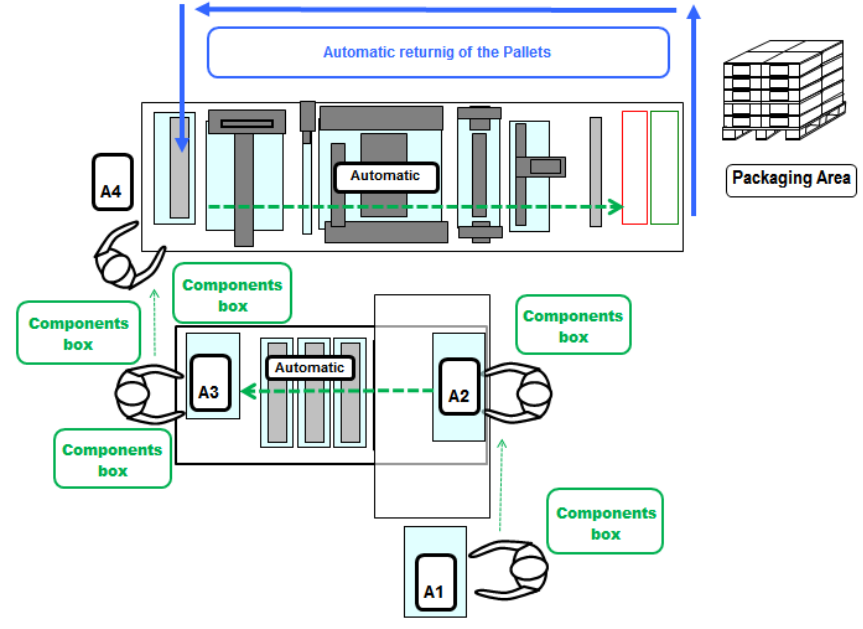
Figure 2. Layout of semi-automated